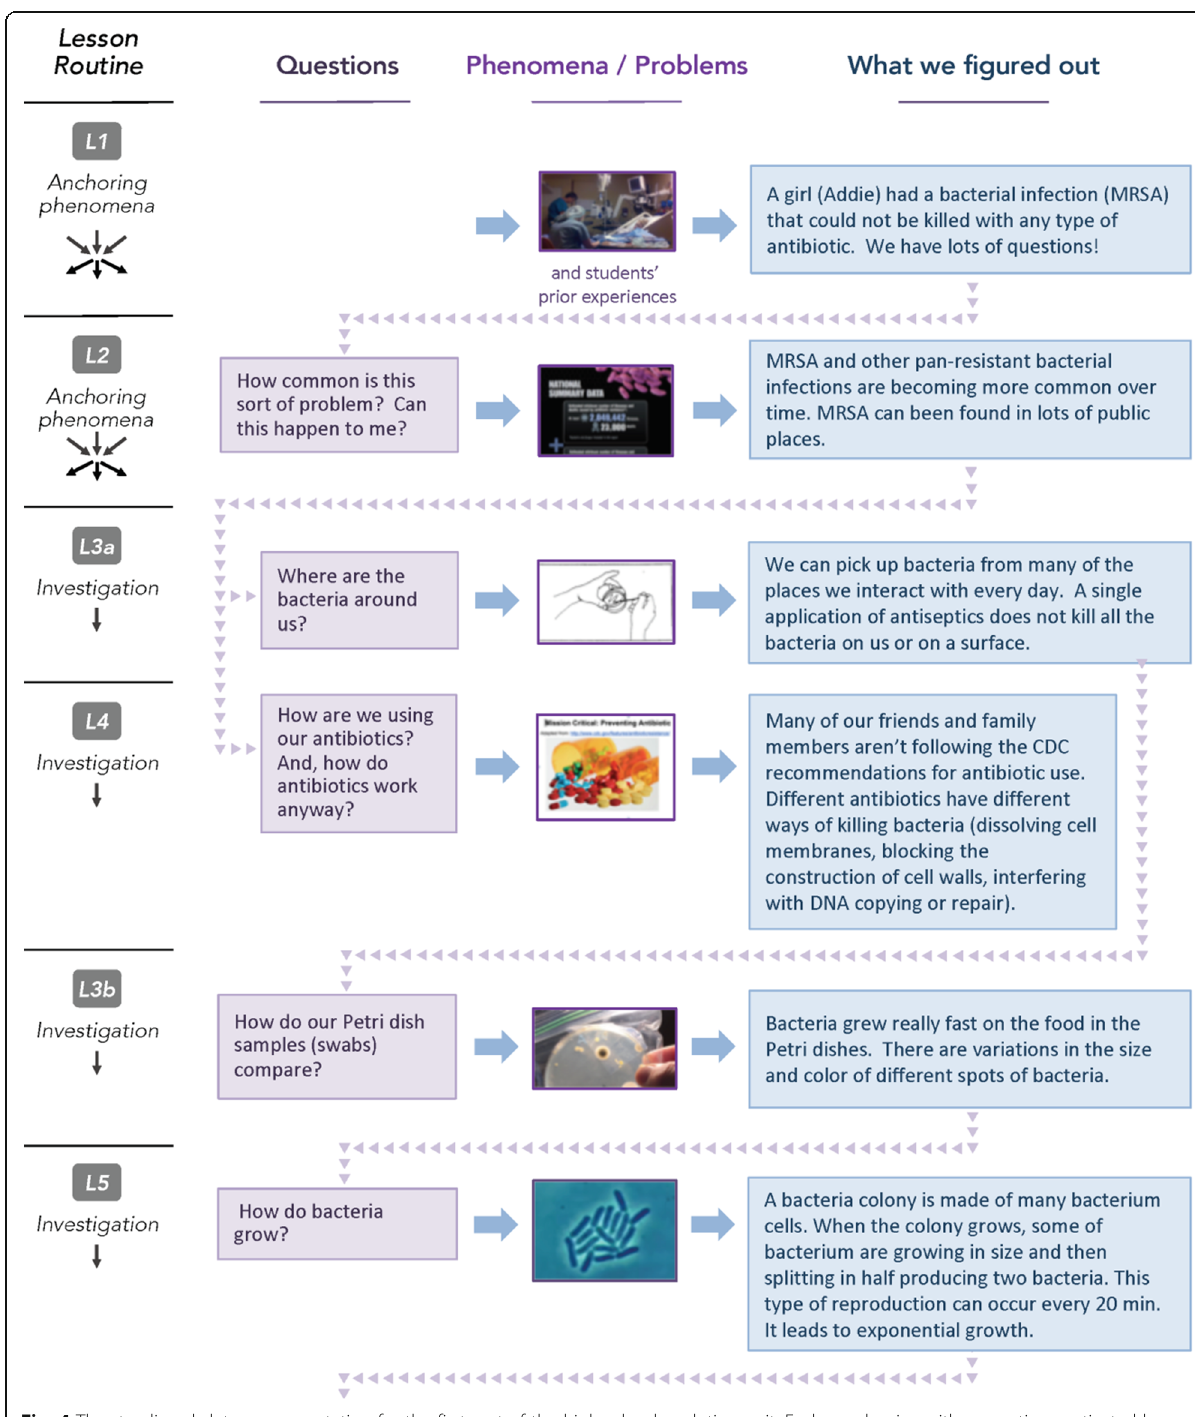
Fig. 4 The storyline skeleton representation for the first part of the high school evolution unit. Each row begins with a question motivated by where students left off the previous lesson. The question leads to engaging with the phenomena through science and engineering practices. What students figure out is shown on the right column. An arrow leads from what students figure out to the question considered in the next